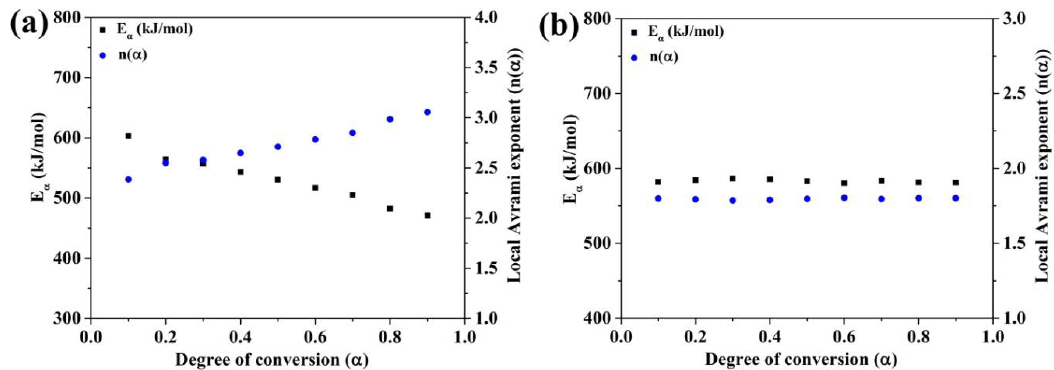
Figure 8. Local Avrami exponent ( n ( α )) and E α as a function of α for ( a ) the first and ( b ) second